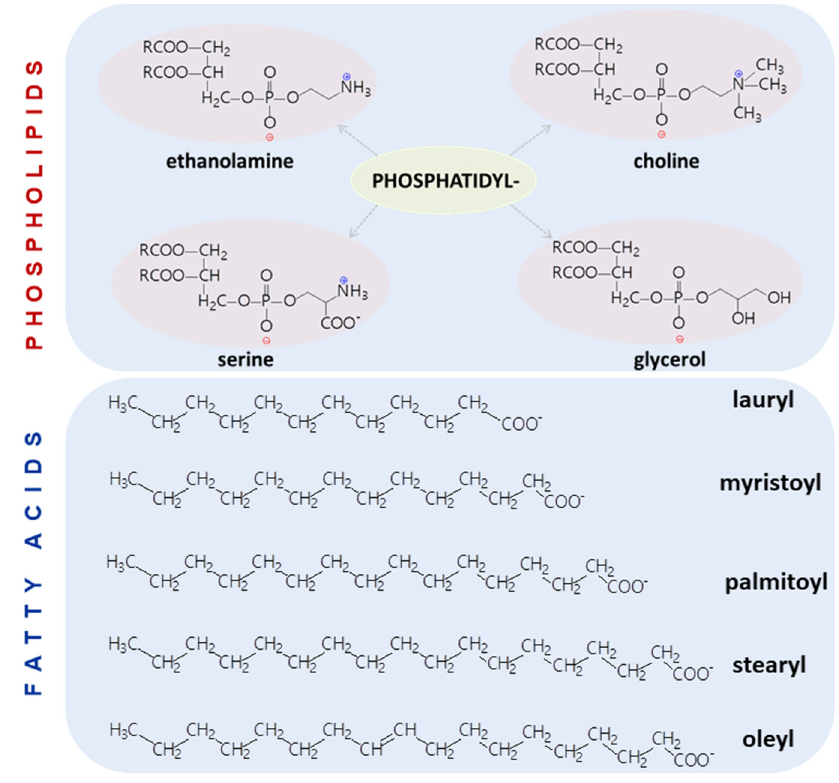
Figure 6. Common phospholipids used for liposomal formulations.